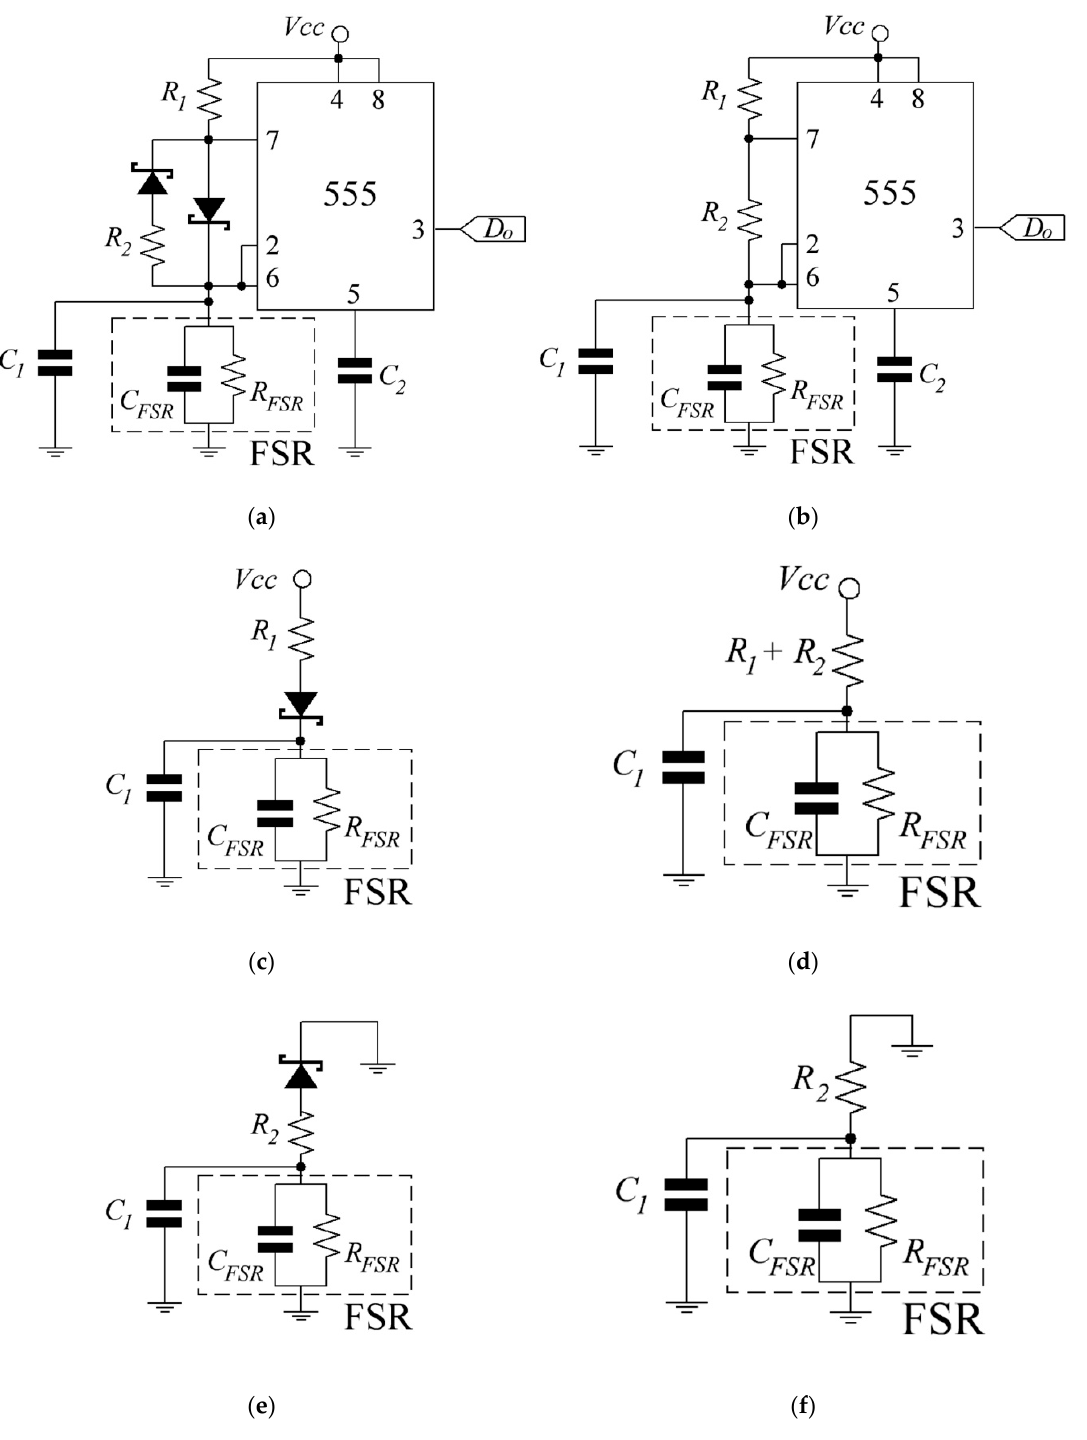
Figure A1. The classical-astable and modified-astable 555 circuits. ( a ) modified-astable 555 circuit for compensating drift and hysteresis in FSRs; ( b ) Classical-astable circuit shown in the datasheet [41]; ( c ) Equivalent charge circuit of the modified-astable 555; ( d ) Equivalent charge circuit of the classical-astable 555; ( e ) Equivalent discharge circuit of the modified-astable 555; ( f ) Equivalent discharge circuit of the classical-astable 555.